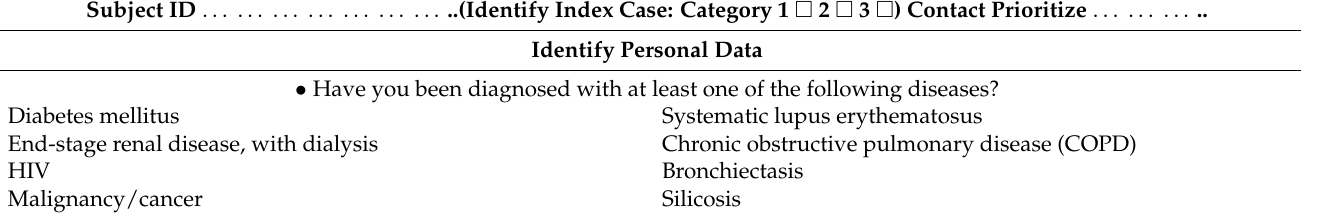
Table A1. Modified Self-Assessment (MSA)